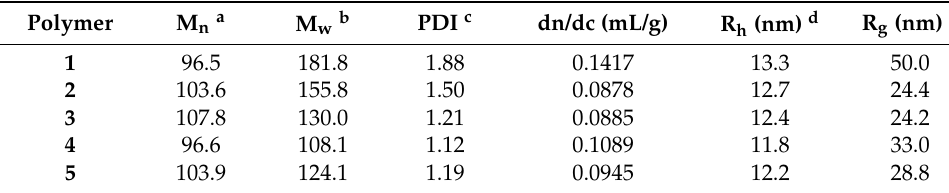
Table 1. Molecular weights of poly(pyridinium salt)-fluorenes 1 – 5 .